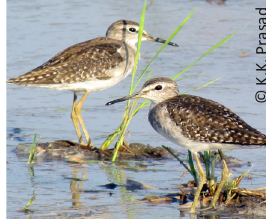
Image 24. Purple Moorhen Porphyrio porphyrio